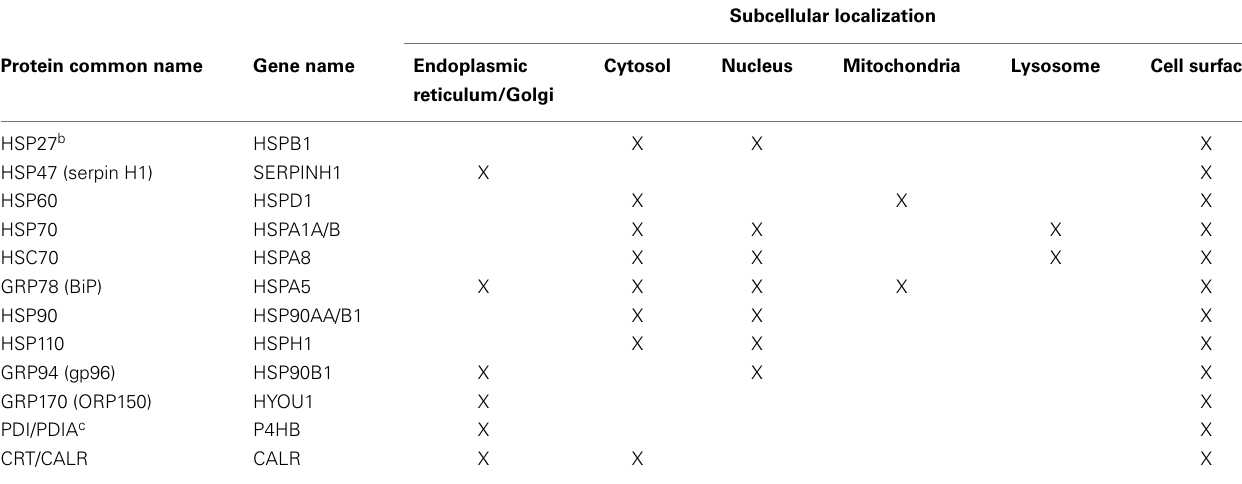
Table 1 | Chaperone proteins described herein and their subcellular localizations .